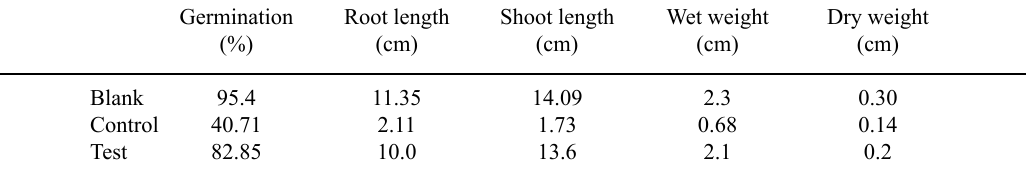
Table 3. Results of Phytotoxicity